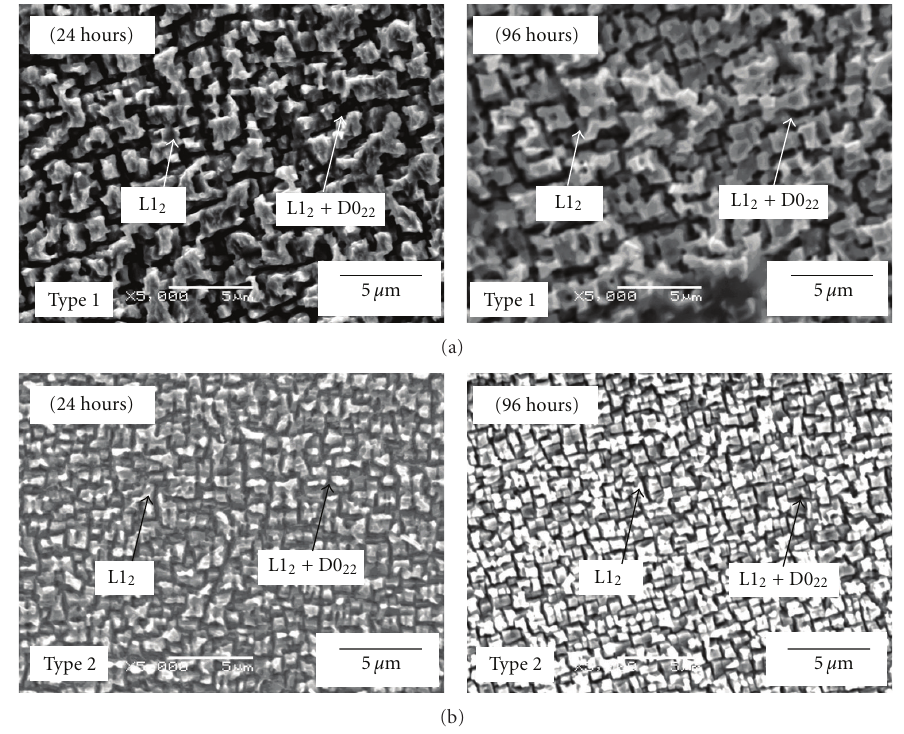
Figure 6: SEM microstructures of Ni 3 Al/Ni 3 V two-phase intermetallic compounds: (a) type 1 and (b) type 2 after the immersion times of 24 hours and 96 hours in 0.5 kmol/m 3 H 2 SO 4 solution at 303